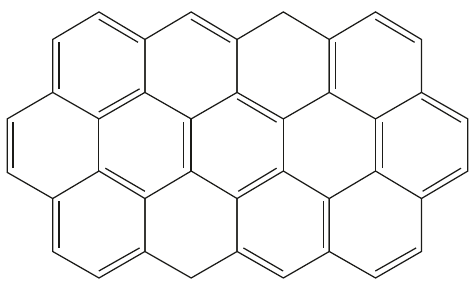
Figure 10: Schematic illustration of graphene photochlorination